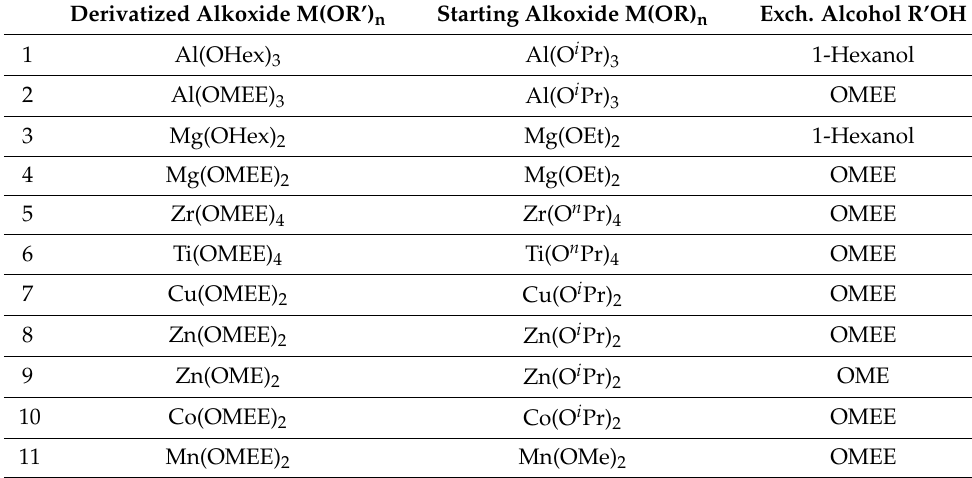
Table 1. Derivatized alkoxides. EF > 0.95 in all alkoxides (OMEE: 2(2-methoxyethoxy)ethanol, OME: 2-methoxyethanol). Derivatized Alkoxide M(OR’)